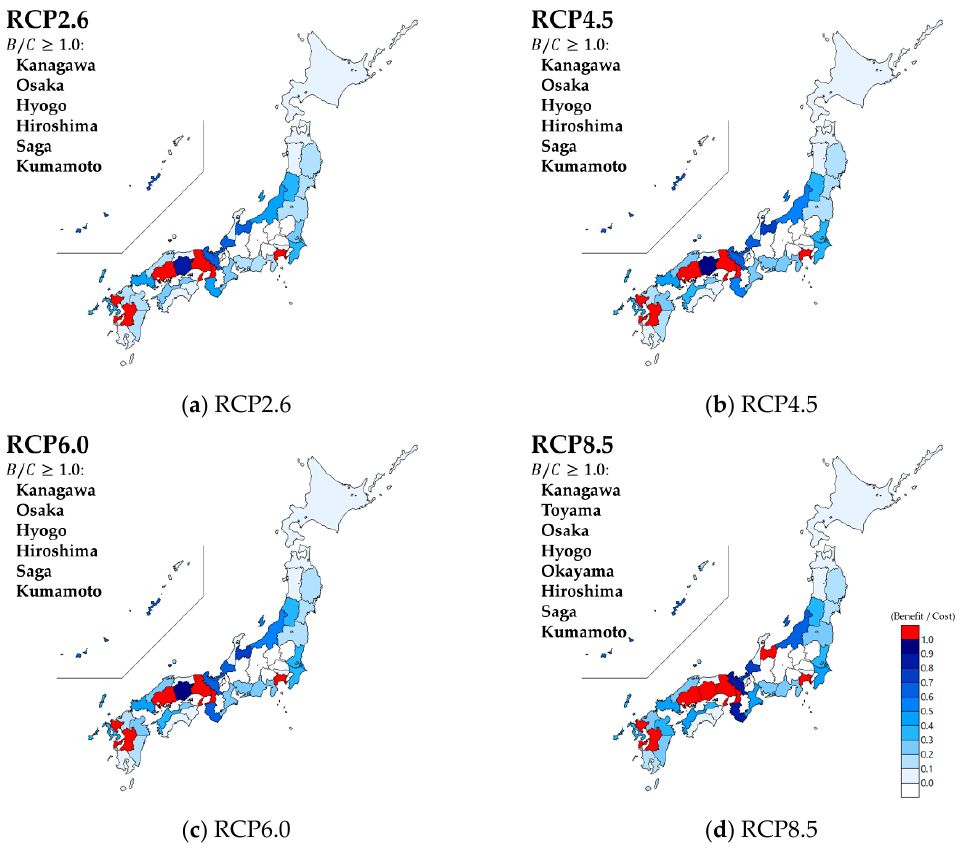
Figure 8. Cost–benefit ratios of adaptation policies in four RCPs in 2081–2100 .